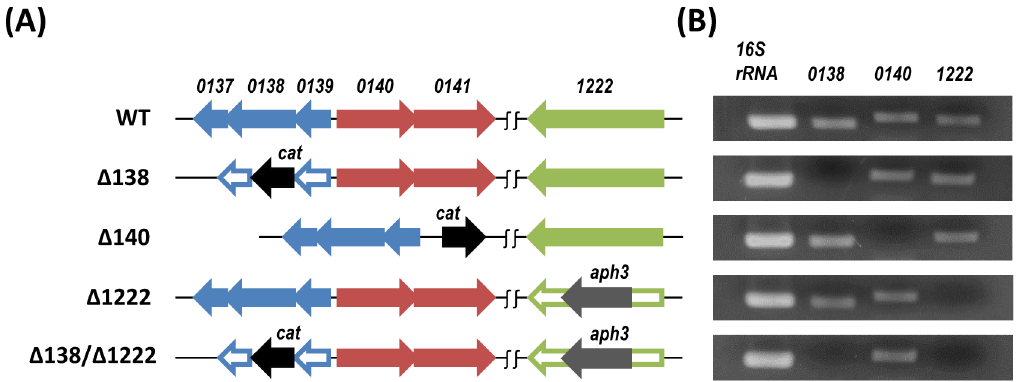
Figure 1. Gene organization of H.pylori 26695 wild type and isogenic mutants (A), and RT-PCR products of relevant genes (B). Colored arrows indicate intact genes, and void arrows indicate inactivated genes. cat ; chloramphenicol resistance gene, aph3 ; kanamycin resistance gene. RT-PCR products were obtained from 30 cycles of amplification.